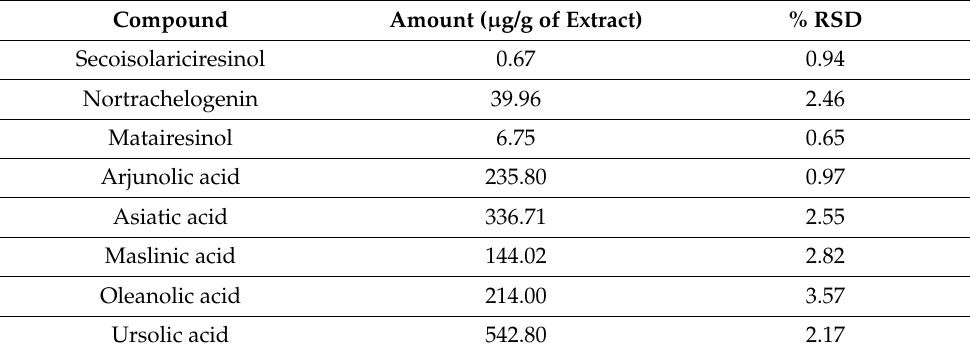
Table 3. Lignanic and triterpenic content.